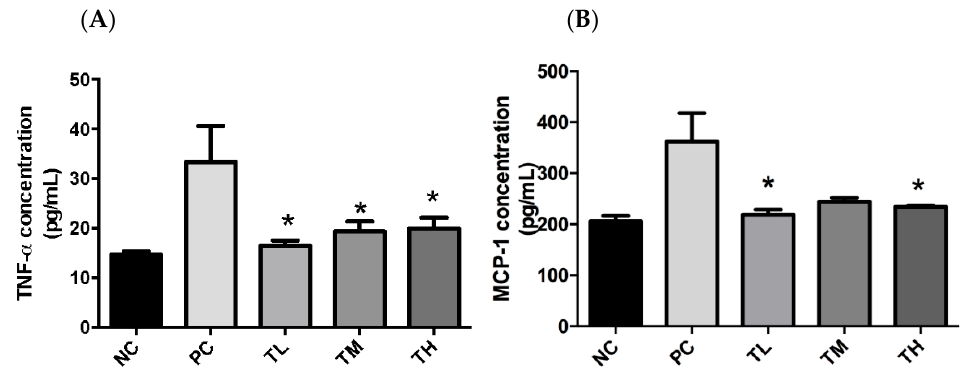
Figure 1. Effect of IMD on pro-inflammatory cytokine expression in the plasma of mice with LPS-induced chronic inflammation. Protein expression of TNF- α ( A ) and MCP-1 ( B ) was measured by ELISA. Results are expressed as means ± SEM of n = 4 samples for NC and PC, and n = 6 samples for TL, TM, and TH. Differences in means were considered statistically significant for p < 0.05. * p < 0.05 relative to PC.